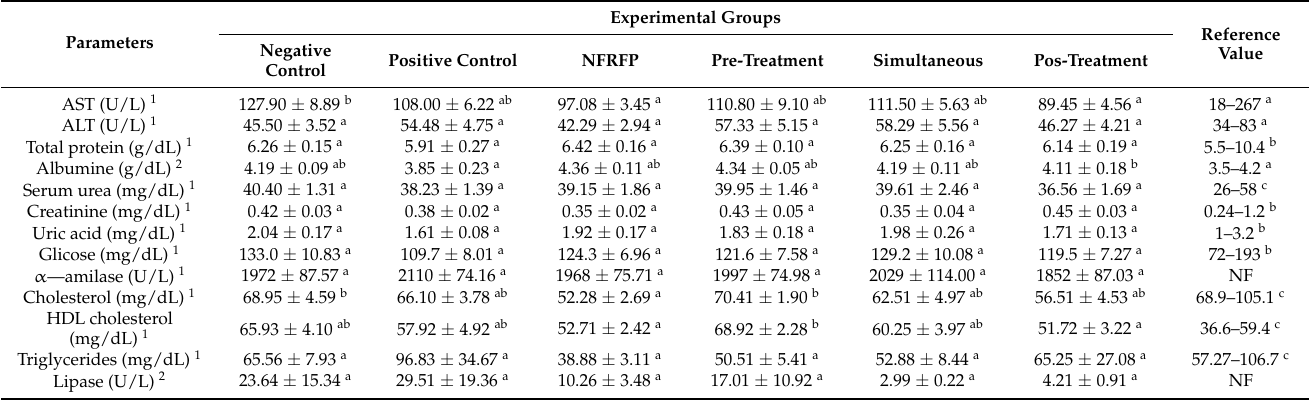
Table 4. Effect of consumption of Natural Fiber-Rich Food Product (NFRFP) on biochemical parameters in rats treated with 1,2-dimethylhydrazine